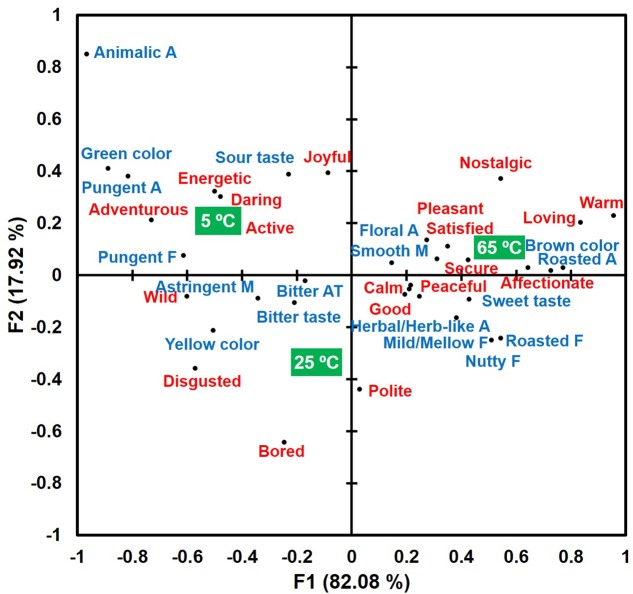
A bi-plot drawn by the correspondence analysis in the associations of sample temperatures with emotional responses (red) and sensory attributes (blue) in green tea samples evaluated at the three temperatures (green squares). “A,” “F,” “M,” and “AT” next to sensory attribute term represent “aroma,” “flavor,” “mouthfeel,” and “aftertaste,” respectively.